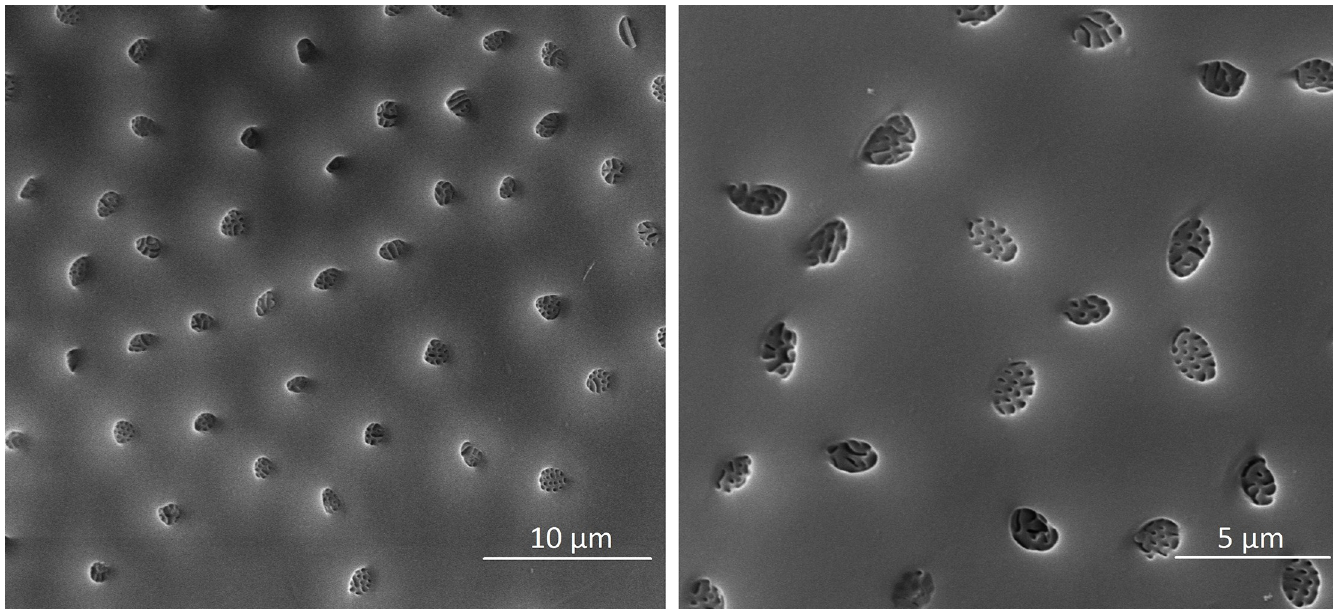
Fig 5. Scanning electron microscopic images of the minor cuticlepores in the cuticle belt of the tergal gland in 8 th abdominal tergite.